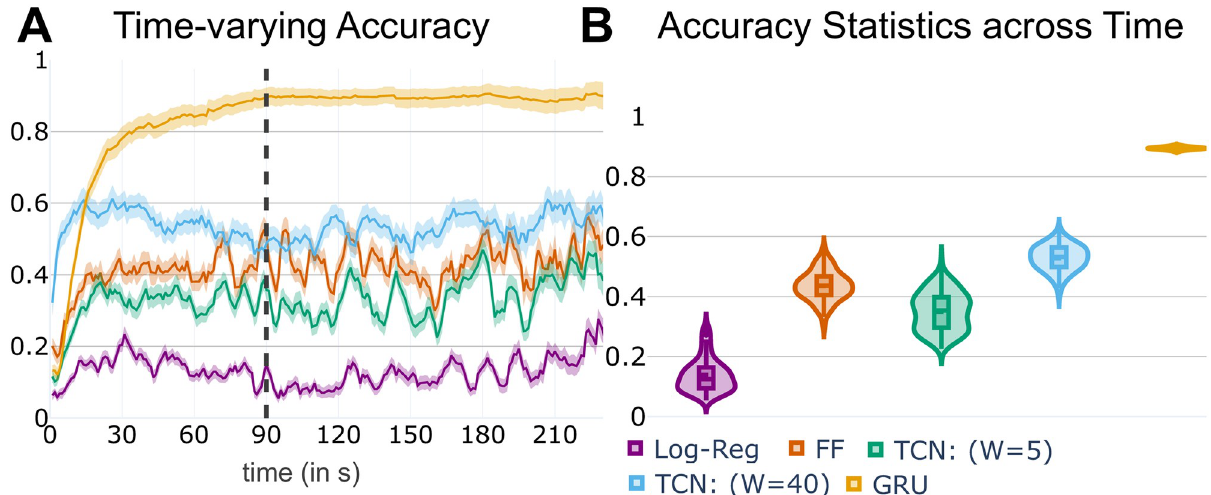
Fig 2. Prediction of movie clip (15-way classification). (A) Average clip prediction accuracy using the neural network architecture with gated recurrent units (GRUs) as a function of time (dark yellow). Accuracy increased sharply during the first 60 seconds, and stabilized around 90 seconds. Results using multinomial logistic regression (Log-Reg), a feed-forward architecture (FF; 1 layer, 103 units), temporal convolutional networks (TCN; kernel widths of 5 and 40) also also shown (see part B for labels). Error bars show the 95% confidence interval of the mean across test participants. (B) Summary of accuracy results after the 90-second transient period (see dashed line in part